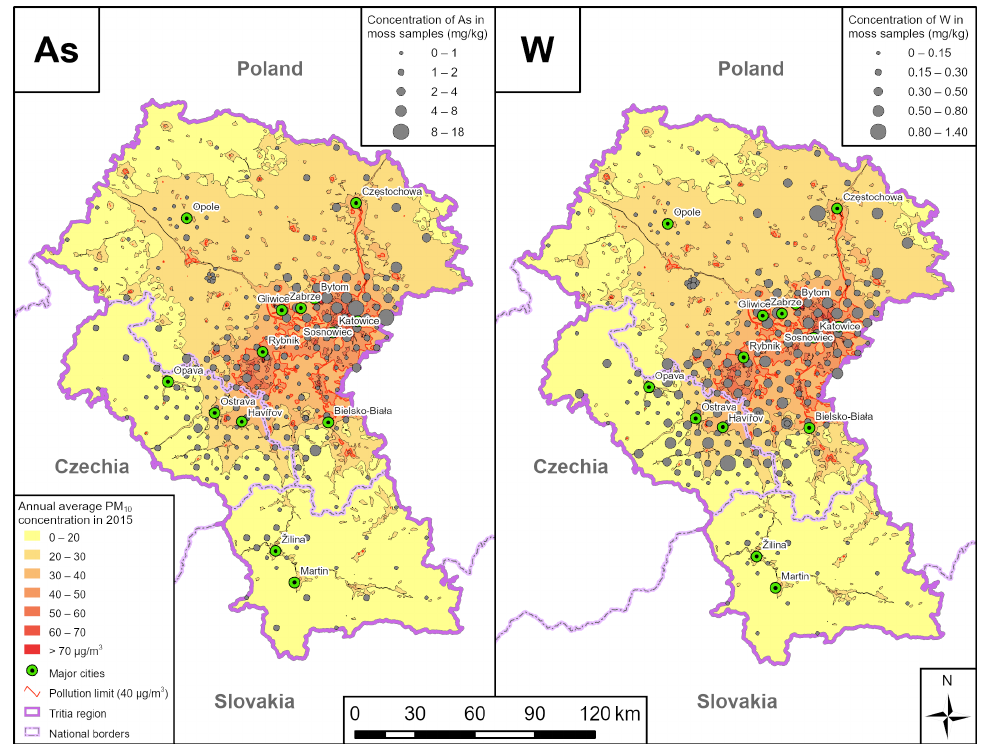
Figure 6. As and W concentrations determined by INAA in mosses and ADMOSS results